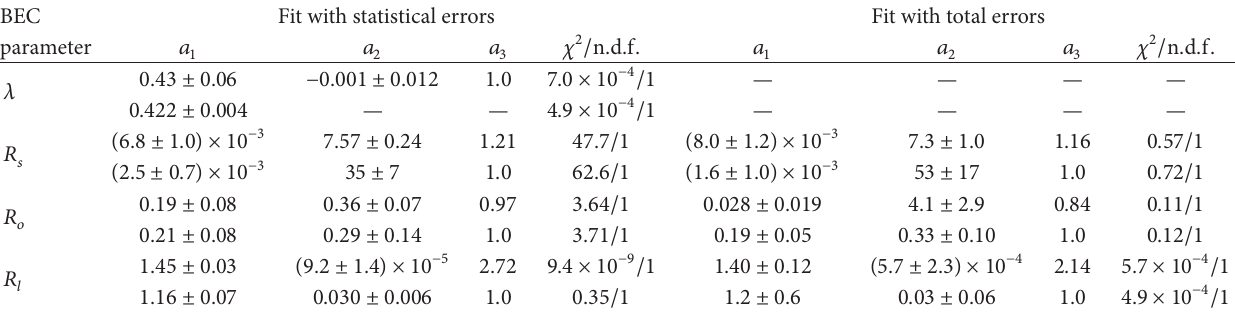
Figure 1: Energy dependence of the main BEC parameters G 𝑖 1 , 𝑖 = 1 – 4 , obtained for 3D Gaussian analyses for 𝑝+𝑝 collisions at midrapidity and low ⟨𝑘 𝑇 ⟩ ≃ 0.2 GeV/ 𝑐 . Errors for experimental points are statistical only. For strength of correlations (a) fit by specific case of (7) at = 1.0 is shown by solid line, and the dashed line corresponds to the fit by constant. For BEC radii (b–d) approximations by function (7) 𝑎 3 are shown by solid lines for case (i.1), and dashed lines present the results for linear logarithmic function in case (i.2). Table 1: Values of fit parameters for approximation of 𝑝 + 𝑝